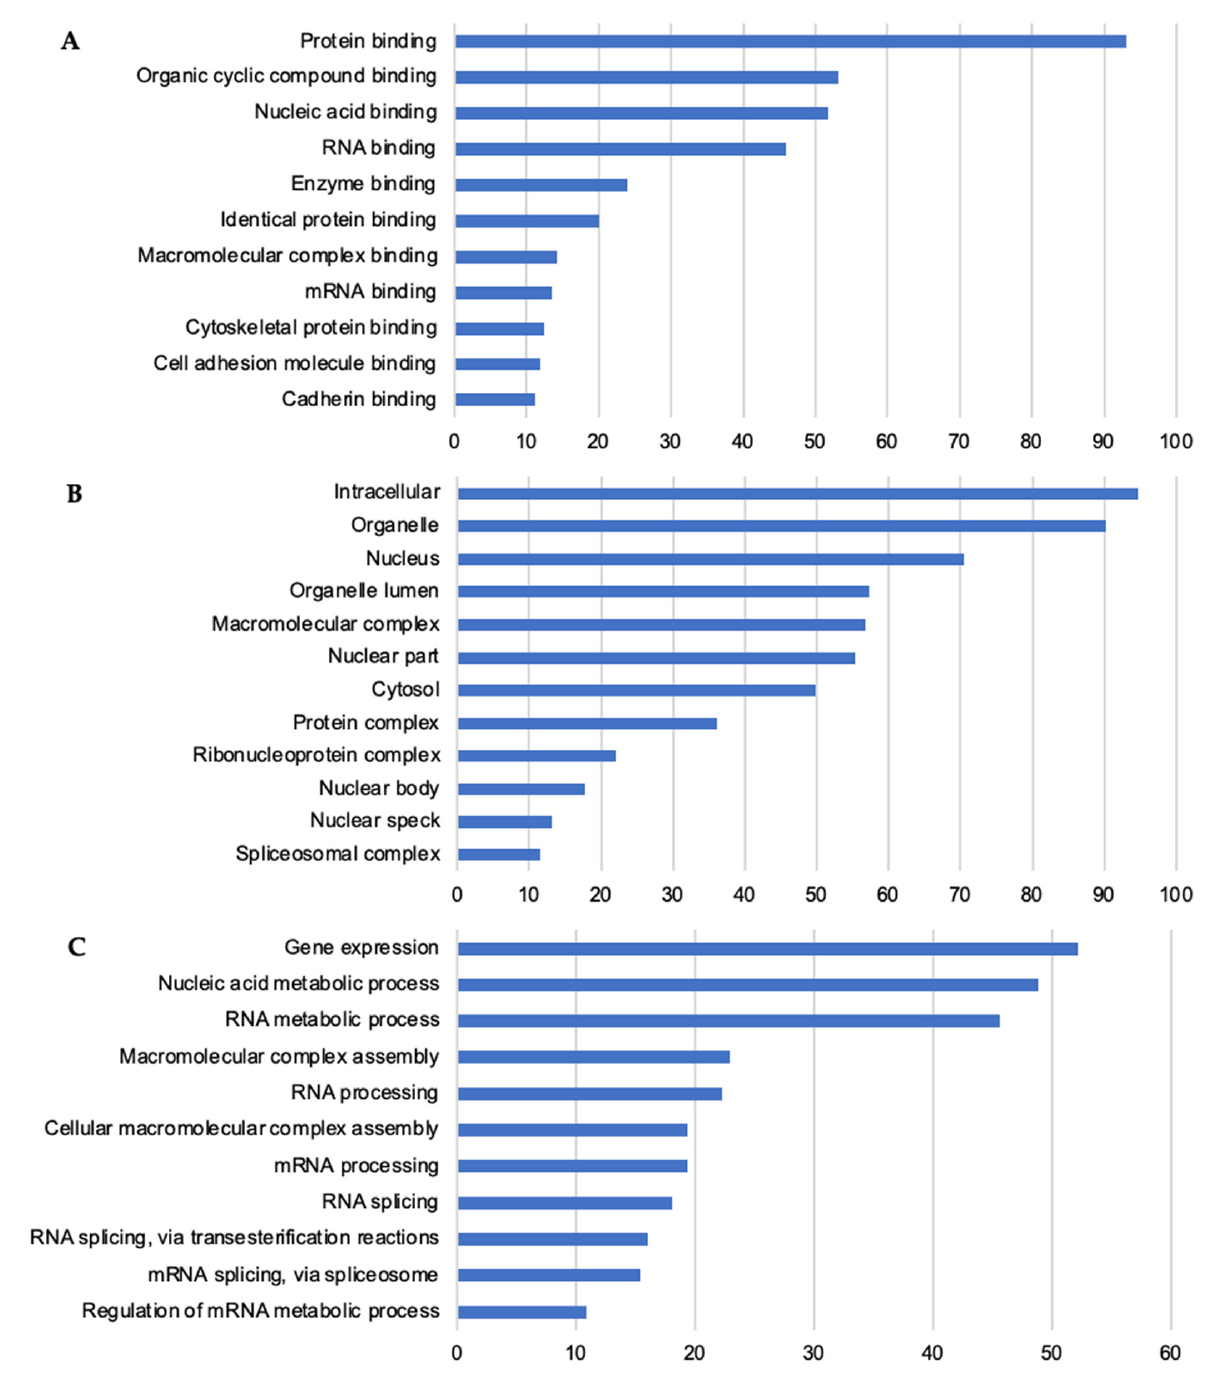
Figure 4. GO analysis of thermostable proteins for ( A ) Molecular Function, ( B ) Cellular Component, and ( C ) Biological Process. x -axis, percent of submitted genes mapping to y -axis annotation. All annotation terms at a false discovery rate < 0.01. Annotations terms graphed above are top 11–12 lowest Benjamini p -values. Overlapping terms and terms returning <10% of submitted genes not shown for space considerations. See Supplementary Table S2 for individual counts, fold-enrichment, and all p -values. Among Cellular Components ( B ), cornified envelope showed a 11.88-fold enrichment but number of returned genes was <10%.